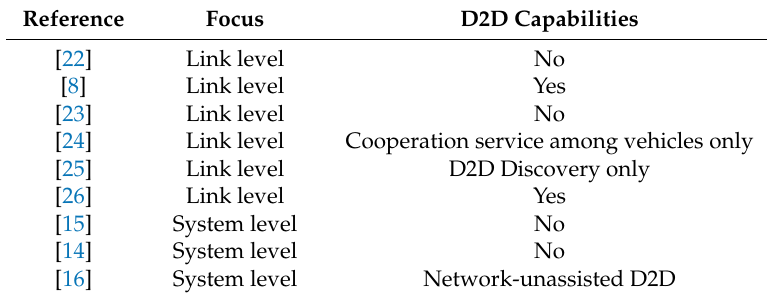
Table 1. Previous work describing existing LTE-A simulators and their D2D